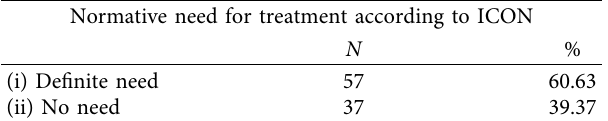
Table 7: Distribution of the percentages of the participants to the Moroccan Arabic version of the MIQ according to the orthodontic treatment need as assessed by the index of complexity, outcome, and need (ICON).